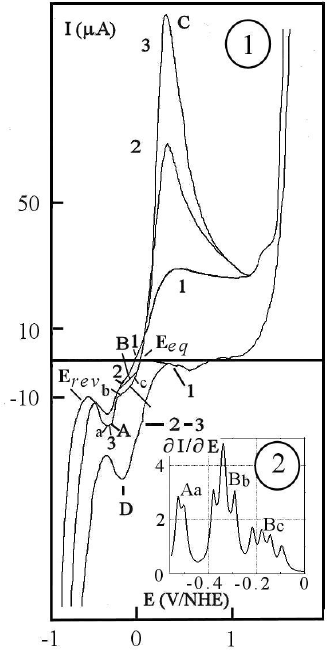
Figure 2. ( 1 ) Voltammetry plot examining the E rev and E eq potentials for palladium charged in hydrogen. Surface area: 0.1 cm 2 , temperature: 20 ◦ C, NaOH: 0.1 mol dm − 3 , scan rate: 200 mV s − 1 , cathodic scan limits: (1) 0 V, (2) − 0.85 and (3) − 1.15 V/NHE, time charging hydrogen τ : 5 s. In window ( 2 ): A(a): on peak A, position a; B(b): between peak A and shoulder B, position b; B(c): on shoulder B, position c. Tiny peaks are small intermediate